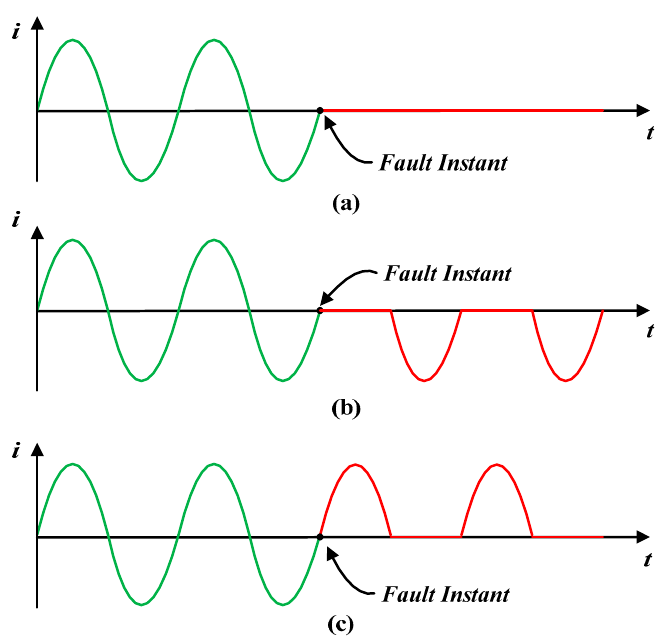
Figure 3. ( a ) OPF or OSF with both upper and lower faulted switches phase current; ( b ) OUSF phase current; and ( c ) OLSF phase current.